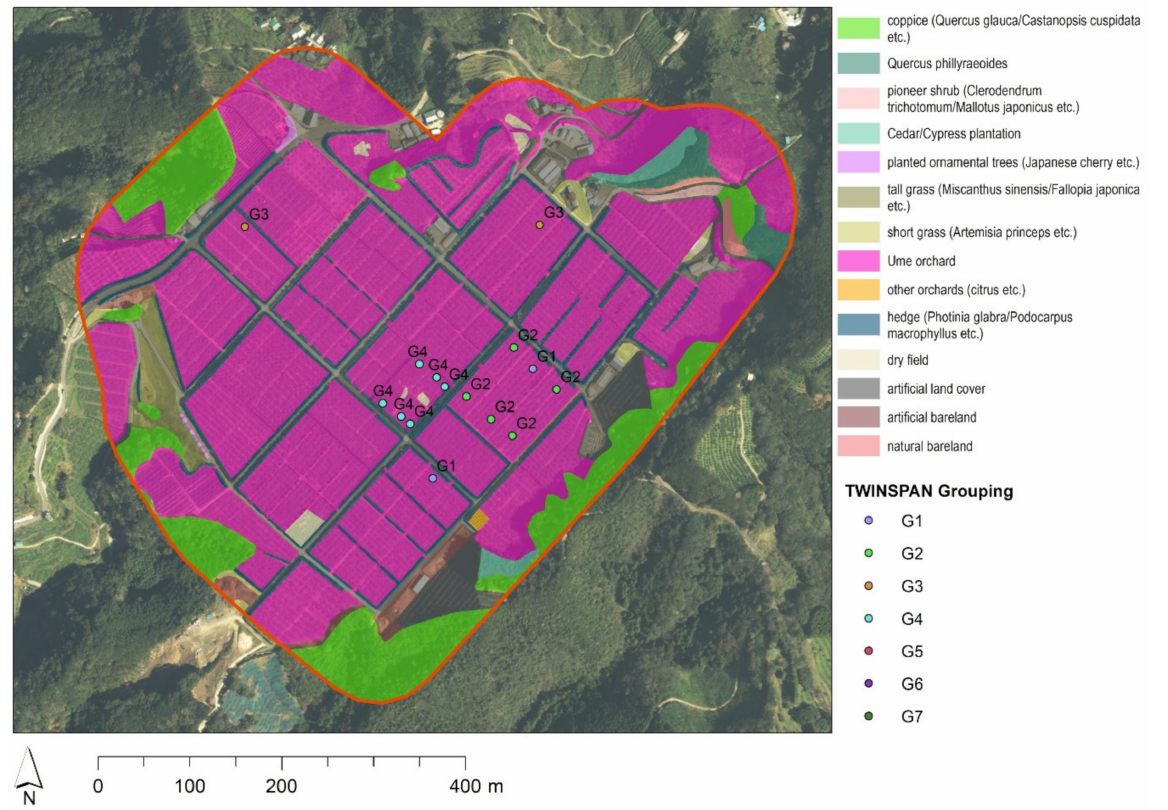
Figure 9. TWINSPAN groupings for cut-fill sites overlaid onto the vegetation